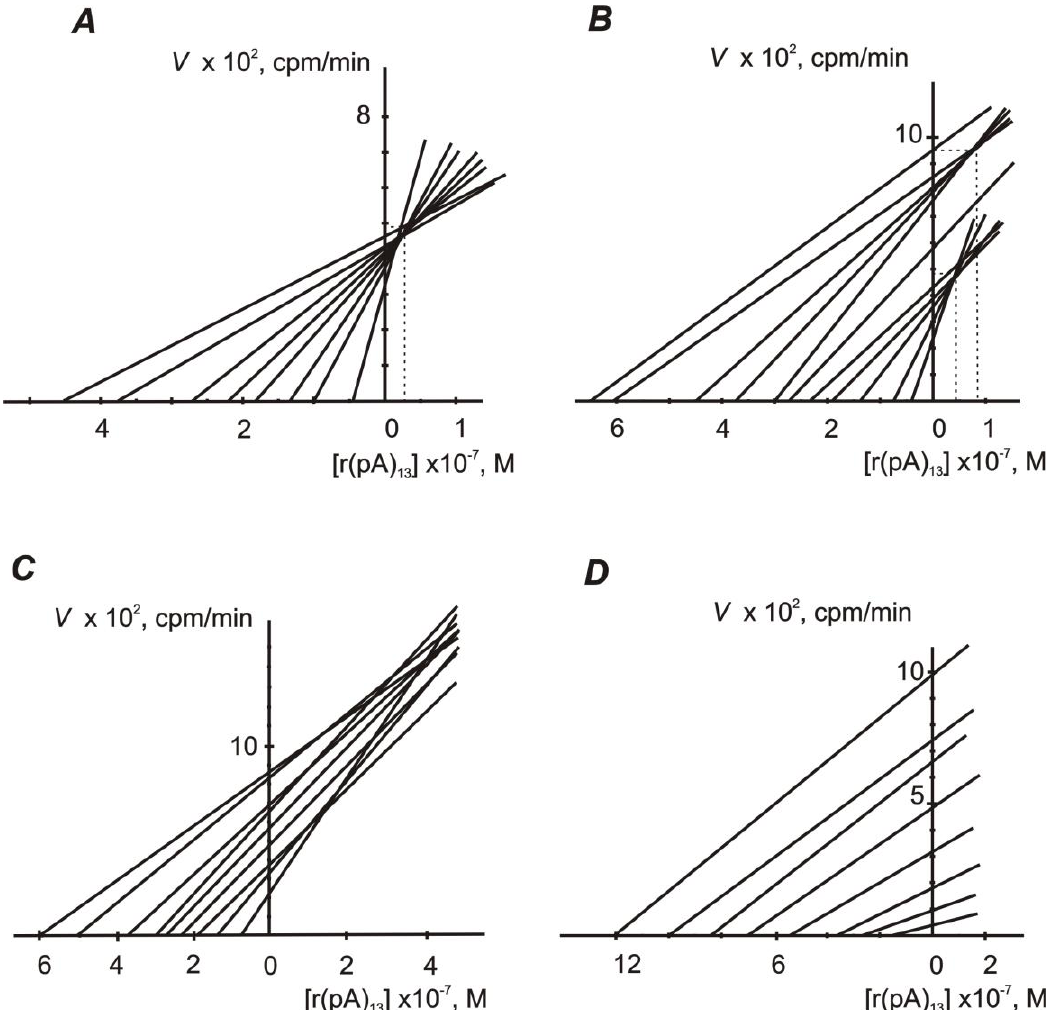
FIGURE 3. Initial rates of IgM-dependent hydrolysis of [5’- 32 P](pA) 13 as a function of its concentration for Ab preparations from sera of four different SLE patients[121]. The K m and V max values were determined from Cornish-Bowden plots (A–D). The common intersection point gives the values of K m and V max in the case of IgM-1 (A) and two values of both K m and V max values for IgM-2 (B); a set of intersection points for (pA) 13 shows a range of K m and V max values of IgM-3 (C); no obvious intersection points are evident in the IgM-4 preparation